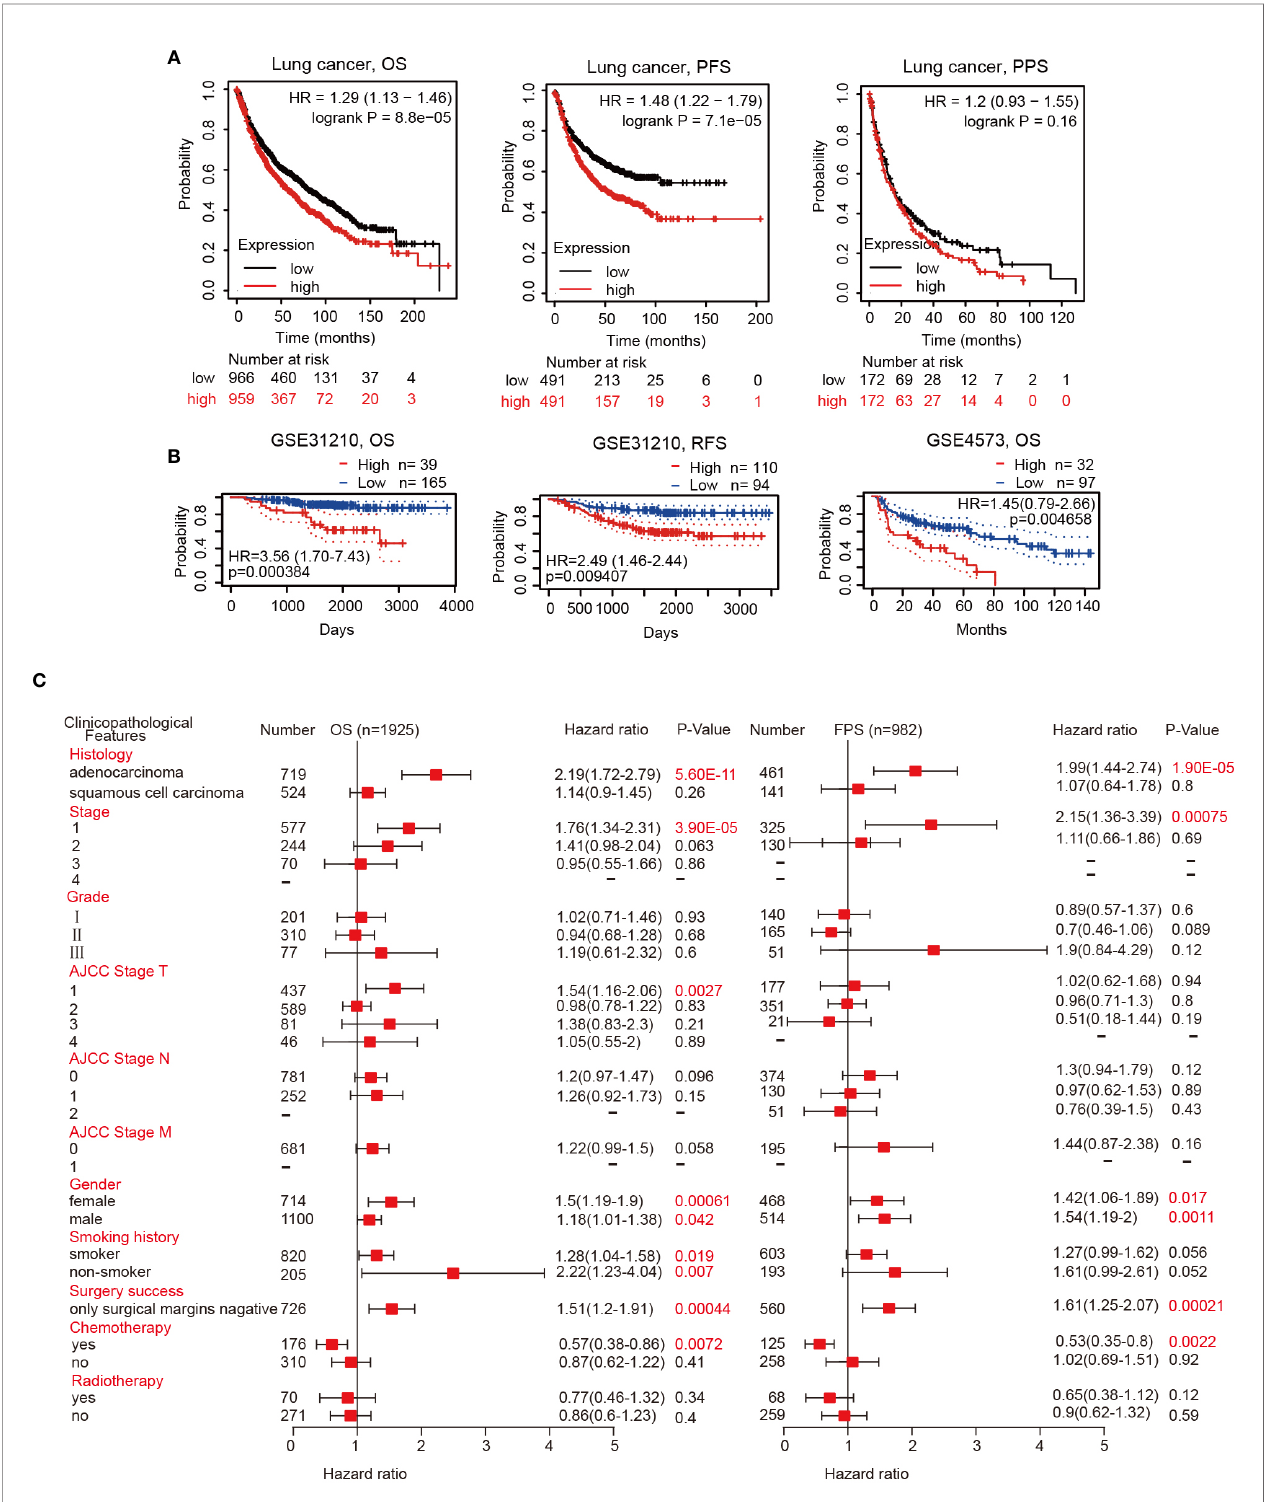
FIGURE 4 | Survival curve evaluating the prognostic value of hepcidin. (A) Survival curves using the Kaplan-Meier plotter are shown for OS, PFS and PPS. (B) Survival curves using the PrognoScan database are shown for OS and RFS. (C) A forest plot shows the correlation between hepcidin expression and clinicopathological parameters in LUAD and LUSC